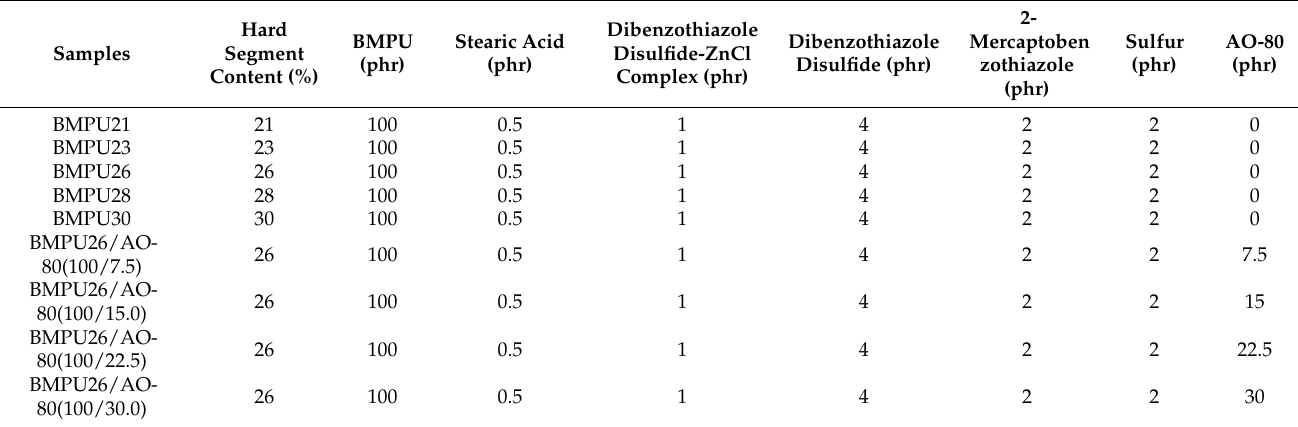
Table 2. Formulations of the BMPUs and BMPU/AO-80 composites.